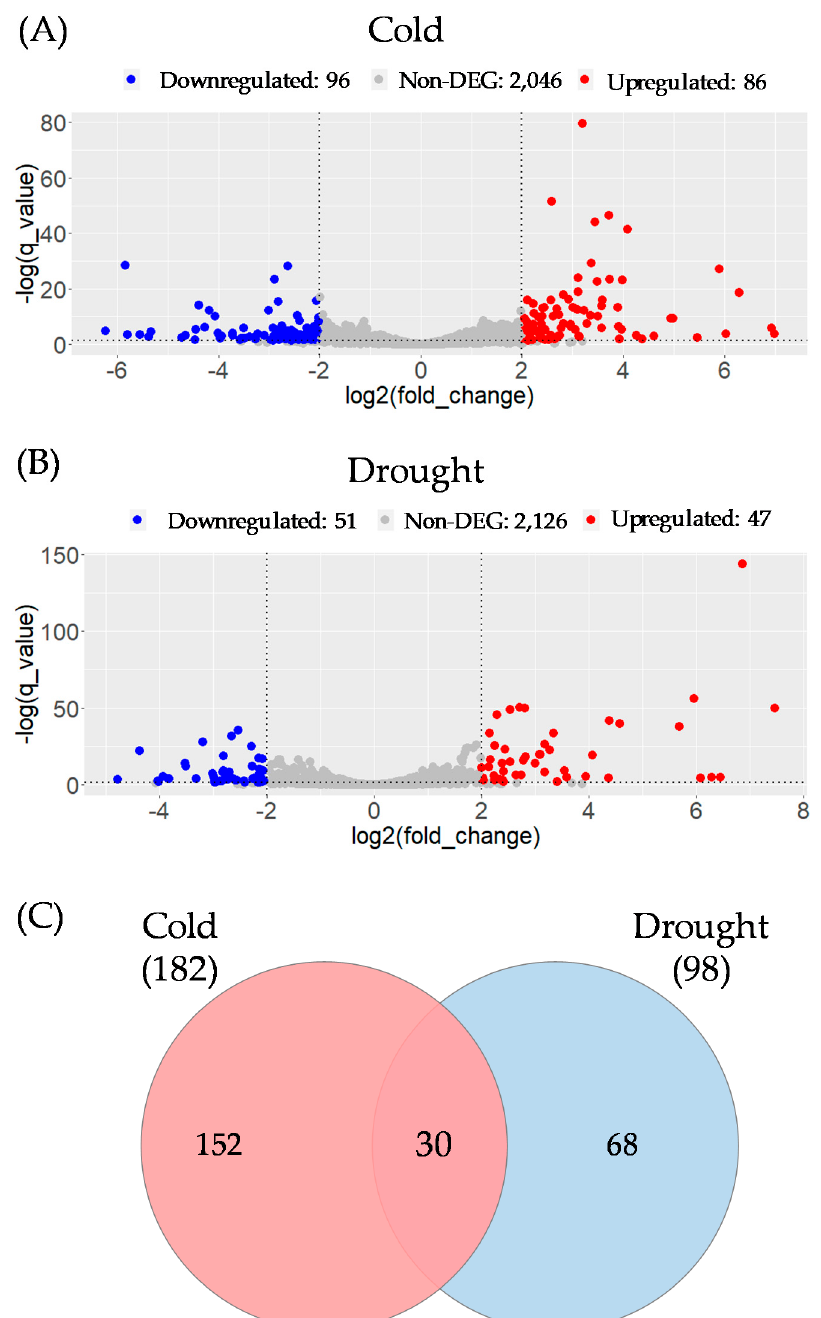
Figure 4. Potential novel lncRNAs with differential expression. Significant differentially expressed lncRNAs under ( A ) cold and ( B ) drought stress in cassava, upregulated or downregulated relative to control. ( C ) Venn-diagram represents differentially expressed lncRNAs under cold and/or drought stress.